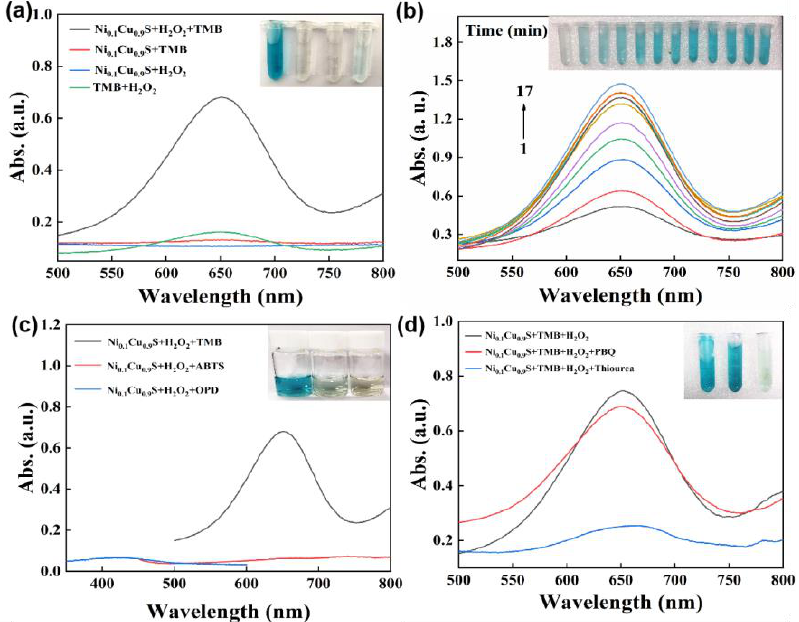
Figure 4. ( a ) The UV–vis absorption spectra of various reaction systems in acetate buffer solution (pH = 5.2) recorded at 10 min. ( b ) The UV–vis absorption spectra over time in the reaction system of Ni 0.1 Cu 0.9 S + H 2 O 2 + TMB. ( c ) The UV–vis absorption spectra of Ni 0.1 Cu 0.9 S + H 2 O 2 + different substrate (TMB, OPD or ABTS). ( d ) The UV–vis absorption spectra of Ni 0.1 Cu 0.9 S + H 2 O 2 + TMB system in the absence or presence of PBQ or thiourea. The insets are their corresponding